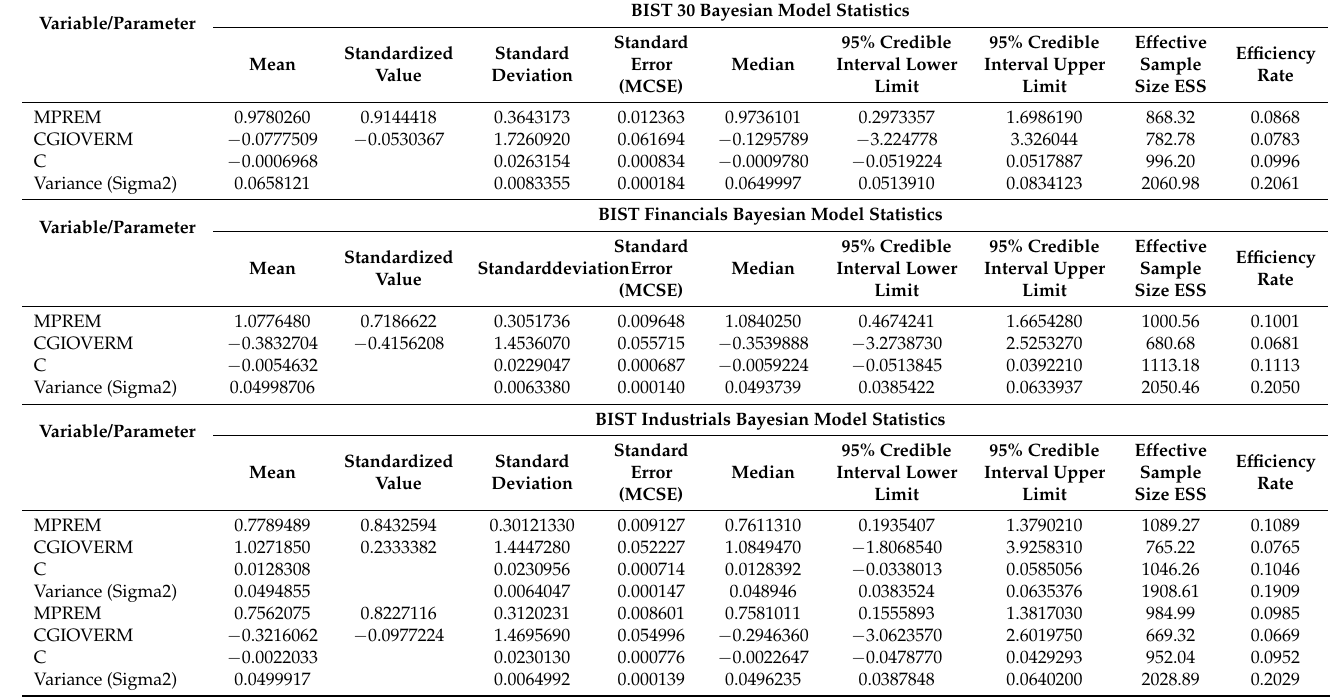
Table 8. Static Bayesian models: